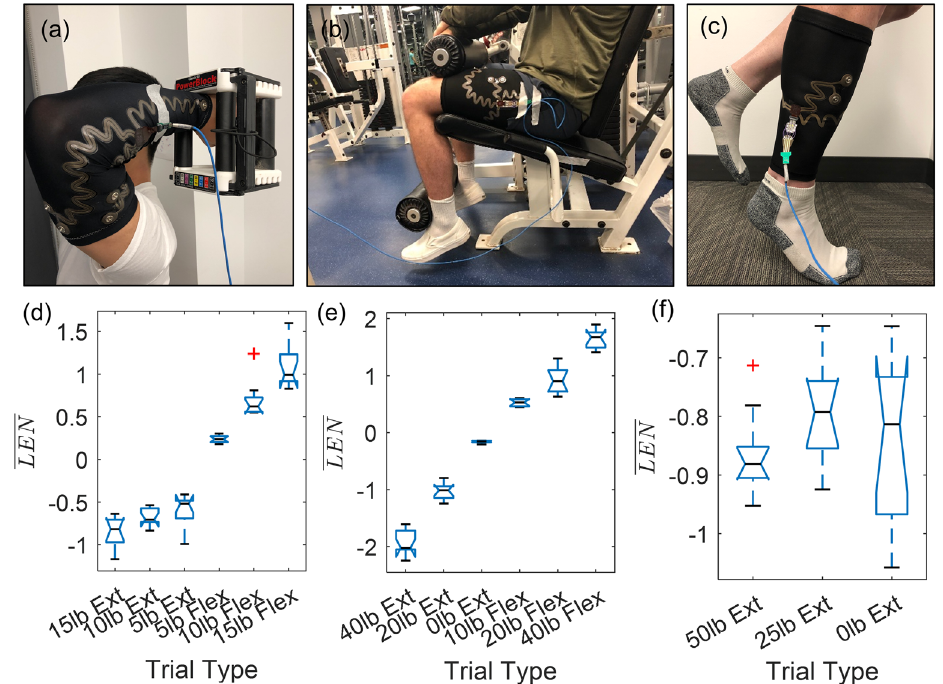
Figure 7. Human subject research testing of sEMG suit with 1 degree of freedom system. Images of experimental set-up for ( a ) the bicep/tricep (elbow), ( b ) quadriceps/hamstring (knee), and ( c ) tibialis anterior/ gastrocnemius (ankle) muscle groups (joints). ( d , e ) Human subject research data showing 1-way ANOVA results for binned level of effort verification for elbow, knee, and ankle extension exercises, respectively (n = 10 trials). Red crosses indicate